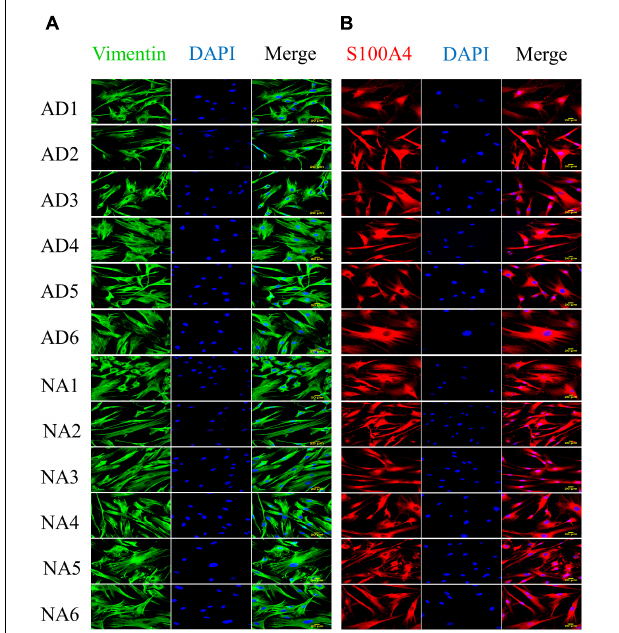
FIGURE 1 | Expression of vimentin and S100A4 in fibroblasts with PS1 mutations (AD) and fibroblasts without the mutation (NA). Protein expression was evaluated by immunocytofluorescence. (A) Expression of vimentin (green) in fibroblasts from control (6) and FAD (6) individuals. (B) Expression of S100A4 (red) in fibroblasts from control (6) and FAD (6) individuals. All cell lines show spindle and lamellar morphologies, and express both fibroblast cell markers. The images were obtained from culture passages 10–20, with a 40 × objective and are representative of 3 determinations. Scale bars correspond to 20 µ